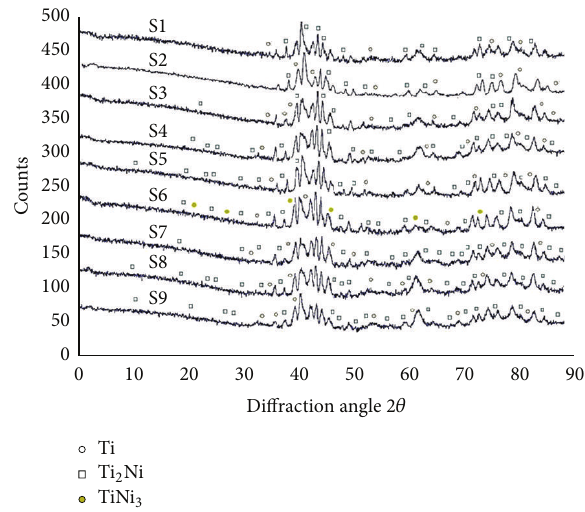
” and longitudinal “ 𝜎 ” yy zz